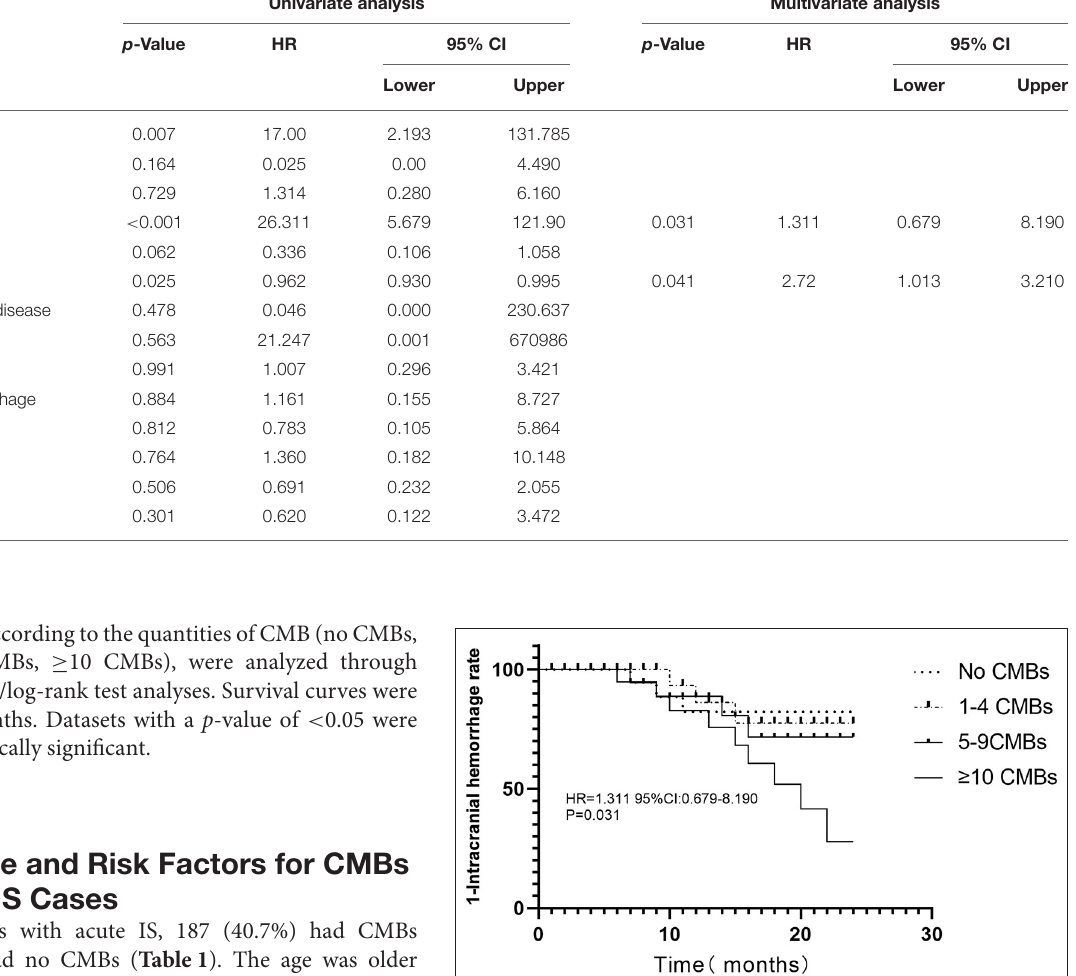
developed recurrent ischemic stroke (RIS), cardiovascular events occurred in 20 (4.44%), and 13 (2.89%) cases led to a mortality due to cardiovascular or cerebrovascular event. Outcomes in patients with/without CMBs are displayed in Table 2 . The incidence of ICH was higher in patients with CMBs than those without CMBs [8.70% (16/184) vs. 2.26% (6/266), p = 0.003] ( Table 2 ; Figure 1 ). Notwithstanding, there were no significant differences in incidence of RIS, cardiovascular events, TIA, and mortality between patients with and without CMBs ( Table 2 ; Figure 1 ). to the numbers of CMBs (i.e., 1–4 CMBs, 5–9 CMBs, and ≥ 10 CMBs) and patients with no CMBs ( Figure 1 ).